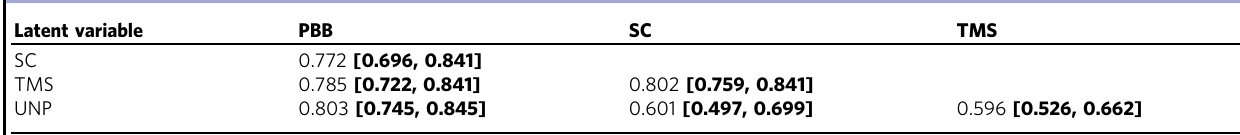
Table 3 Discriminant validity assessment based on HTMT 0.85